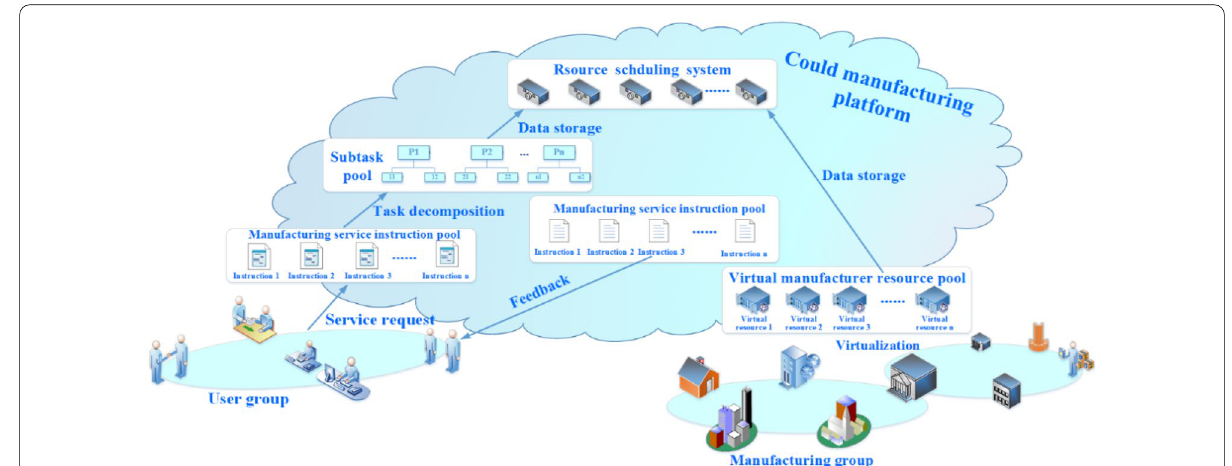
Figure 12 Cloud manufacturing architecture and online data